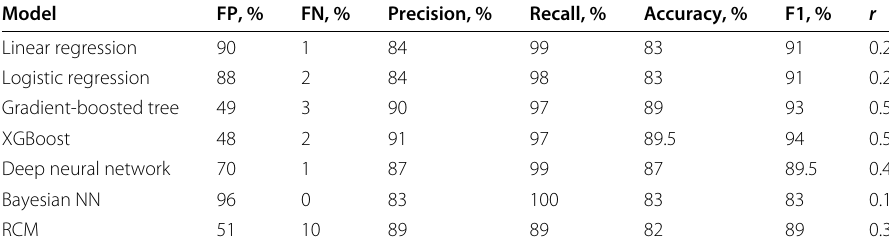
Table 5 Evaluation results with reading features